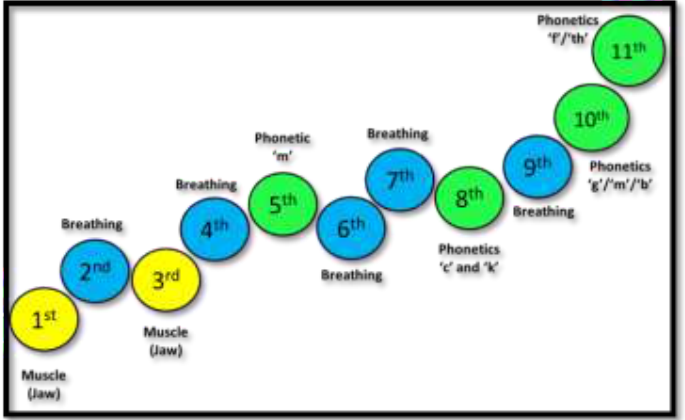
Figure 1. Steps of Speech-Language